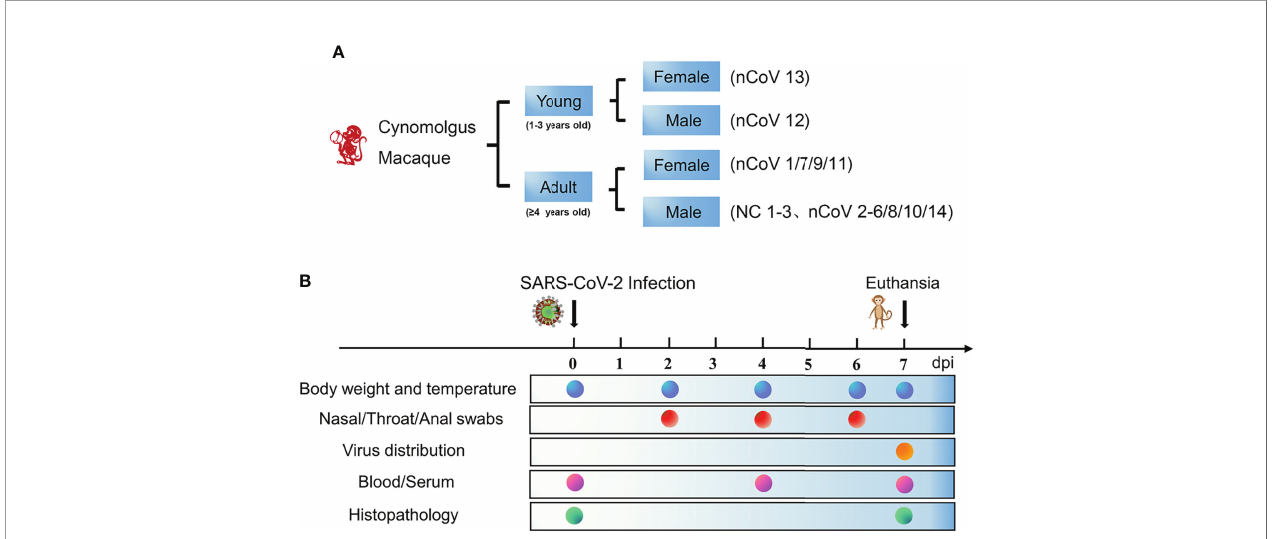
FIGURE 1 | Schematic of the study design and clinical signs of SARS-CoV-2 infection in CMs. (A) Two age groups of monkeys (14 in total) were selected for this study to assess their ability to establish COVID-19 model. The monkeys were randomly assigned into two groups, the detail of age and sex were demonstrated. (B) The body weight and temperature, swabs, tissues and blood were collected at the indicated time points for evaluation of clinical symptoms, viral shedding and replication, and host responses to SARS-CoV-2. CMs, cynomolgus macaque; NC, negative control; nCoV,